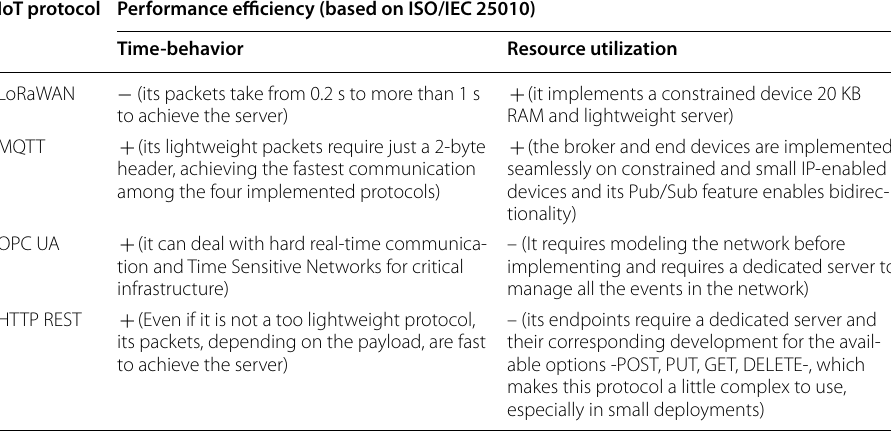
Notation: means High performance, – means Low performance +